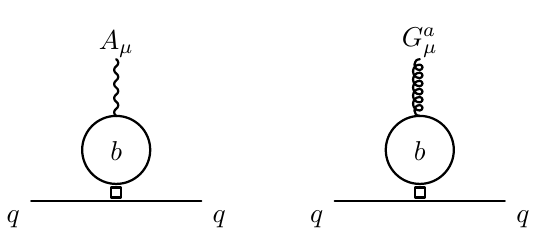
Figure 5 . Sample Feynman diagrams whose finite parts contribute to the calculation of the match- ing corrections at the respective heavy-quark thresholds (shown here for the case of the bottom